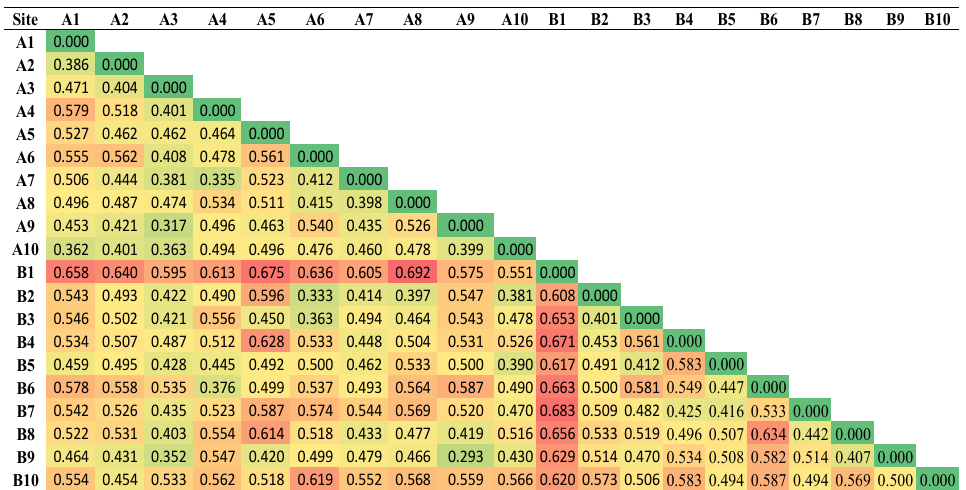
Figure 5. The dissimilarity matrix among the sampled sites of the seawater in both investigated areas.